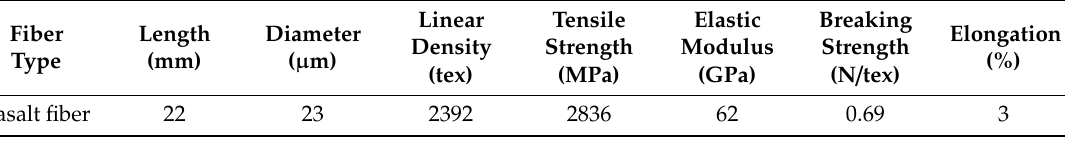
Table 1. Basic properties of basalt fibers.